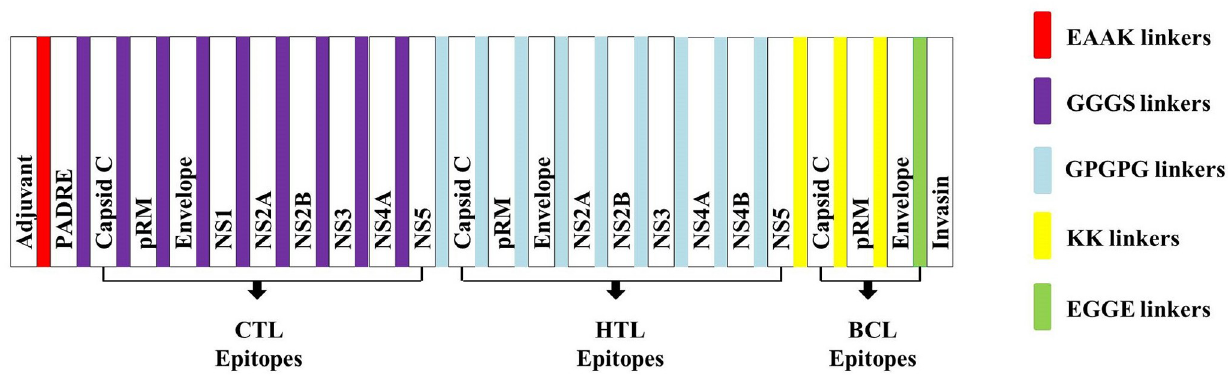
Fig 5. Schematic representation of WNV vaccine construct: A 488 amino acids long multi-epitope vaccine sequence consisting an adjuvant at N- terminal end linked with a multi-epitope sequence with the help of EAAAK linker (Red) followed by PADRE sequence. CTL epitopes were linked through GGGS linkers (blue). HTL epitopes were linked through GPGPG linkers (Sky). BCL epitopes were linked through KK linkers (Yellow). Invasin molecule linked through EGGE linker (Green).